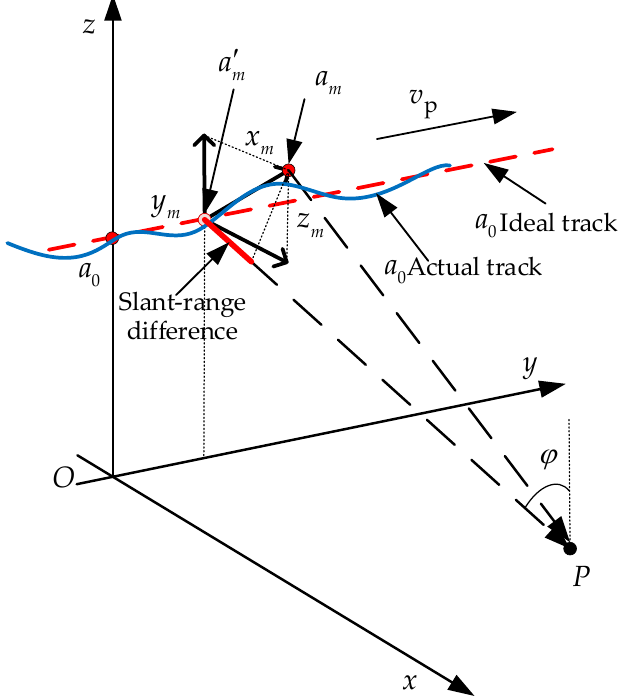
Figure 1. The geometry of the distributed SAR.